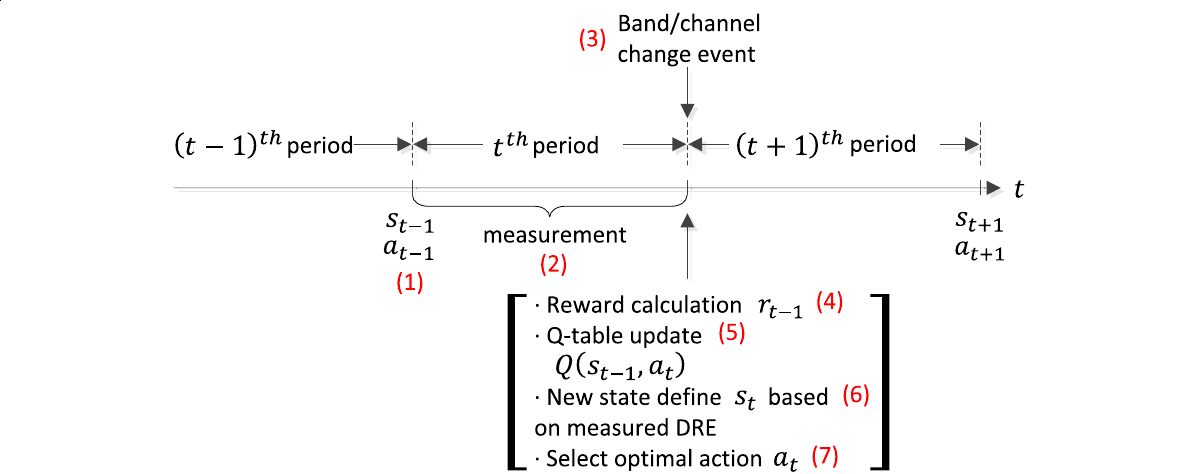
Fig. 6 Proposed procedure for Q-table update, state determination, and action selection. (1) Suppose the learning agent CH determined the state s t − 1 and the best action a t − 1 at the end of ( t − 1)-th time period. (2) During t -th time period, MNs and CH monitor the primary activities and channel statistics. (3) Agent CH detects the band and channel change event. (4) The CH calculates the reward r t − 1 for the previous action a t − 1 at state s t − 1 . (5) The CH updates the Q-value of ( s t − 1 , a t − 1 ) in Q-table. (6) The CH determines the current state s t based on the measured DRE during t -th time period. (7) The CH selects the optimal action a t for the next ( t + 1)-th time period. (8) Go to step